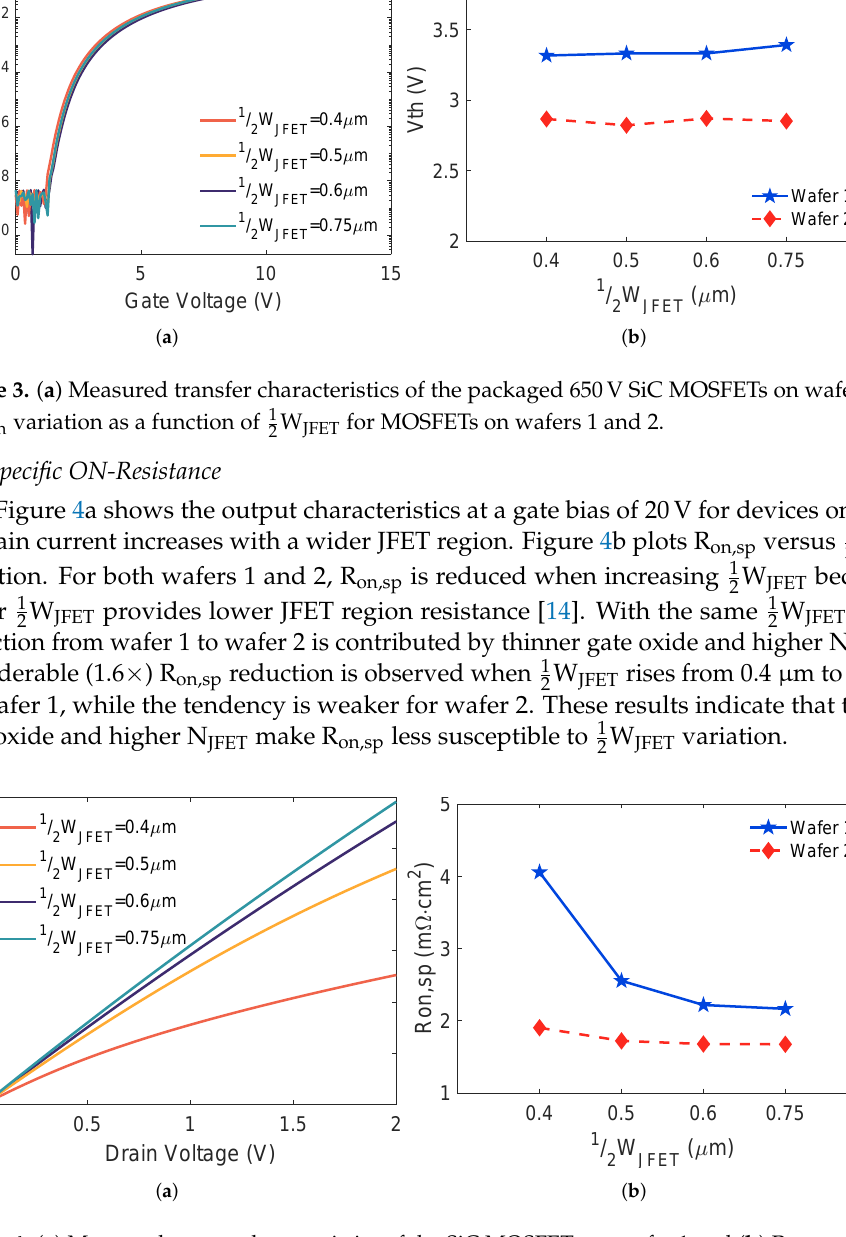
Figure 4. ( a ) Measured output characteristics of the SiC MOSFETs on wafer 1 and ( b ) R on,sp variation as a function of 1 W JFET for MOSFETs on wafers 1 and 2